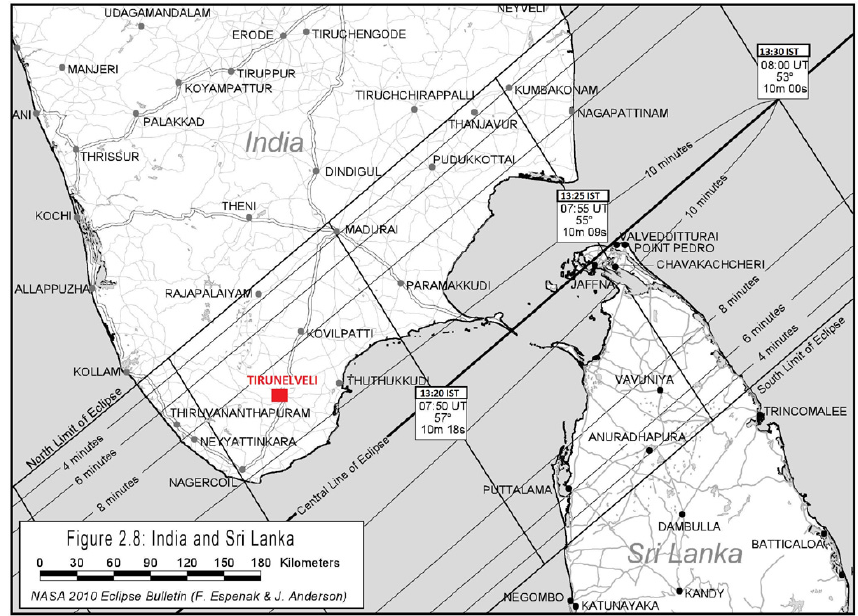
Fig. 1. Map describing the detailed path of the 15 January 2010 annular solar eclipse over India and Sri Lanka. The station Tirunelveli is shown on the map in filled red square.